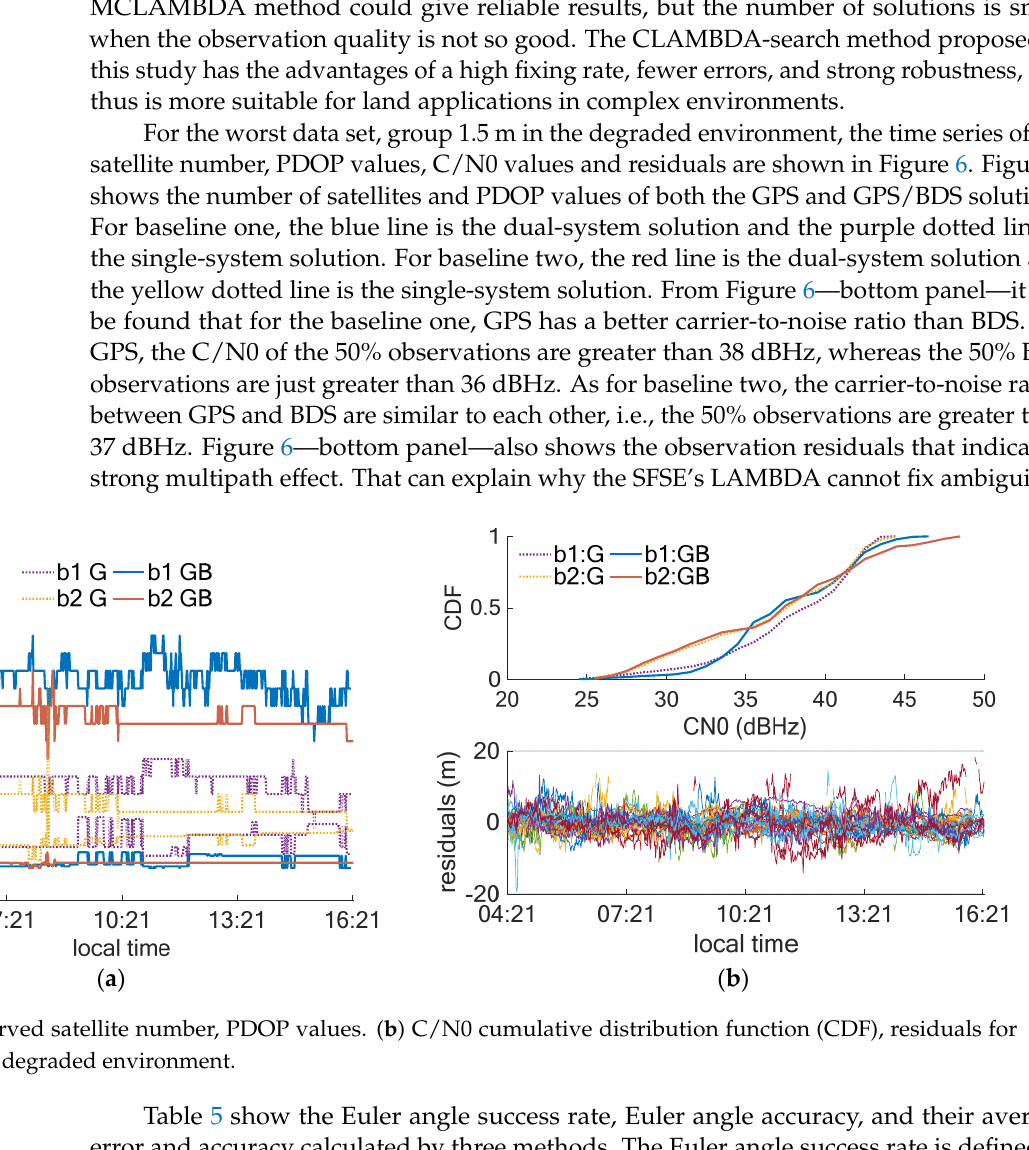
Table 5. GPS/BDS attitude solution of group 1.5 m in degraded environments.